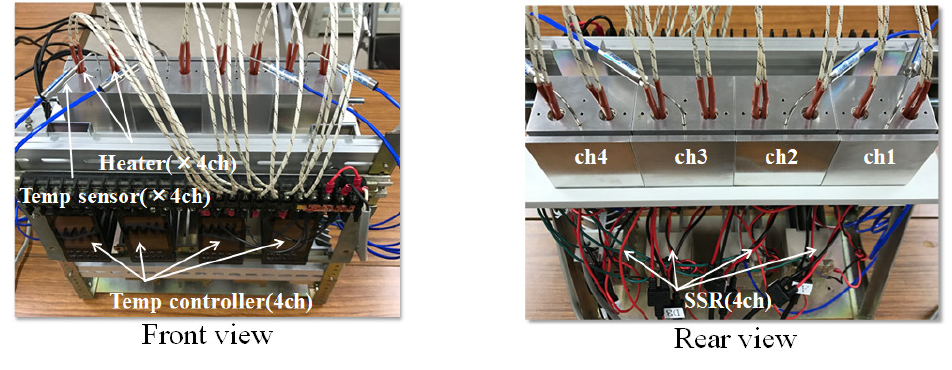
Figure 9. Experimental